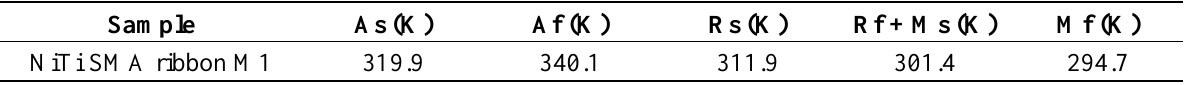
Figure 5. Comparison of DSC curves between the magnetic hybrid material, the NiTi ribbon and the composite material M1. Table 1. Transformation temperatures of the SMA ribbon M1, obtained by DSC.